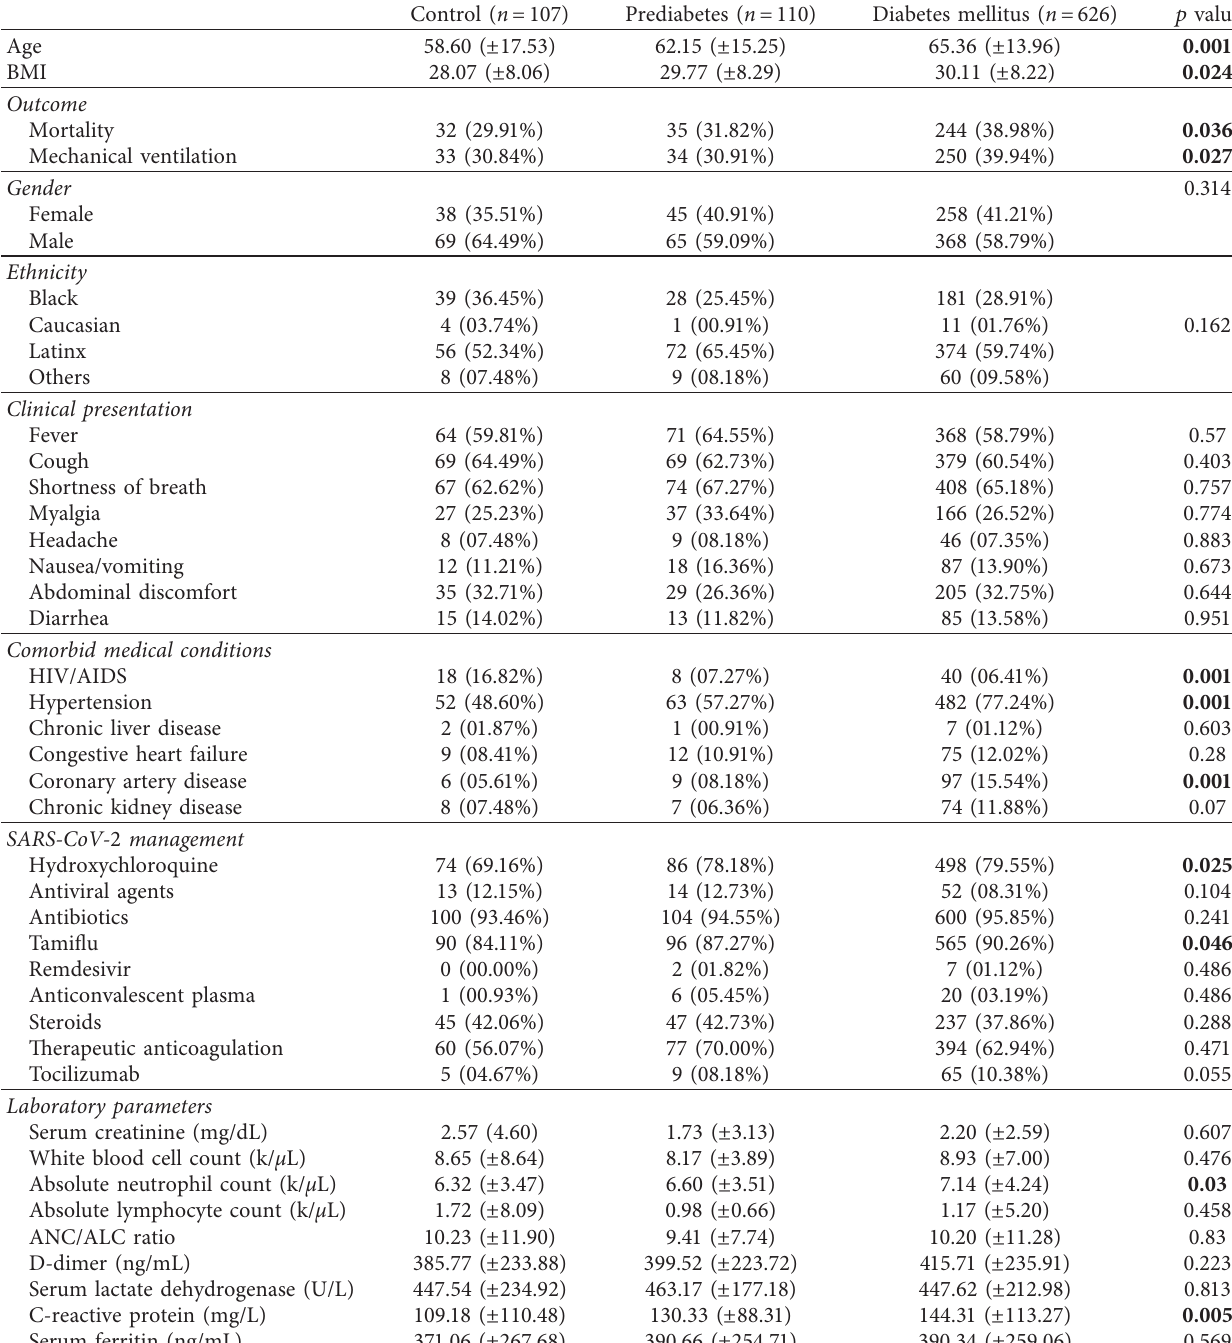
Table 1: Comparison of demographic, clinical, and laboratory variables among three